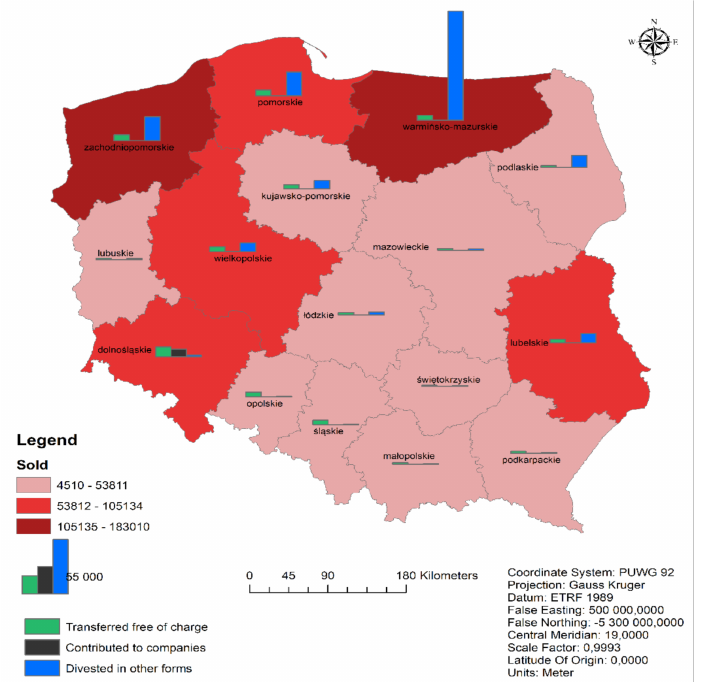
Figure 3. Management of agricultural land by the NASC in Poland, divided into voivodships, between 2006 and 2018.